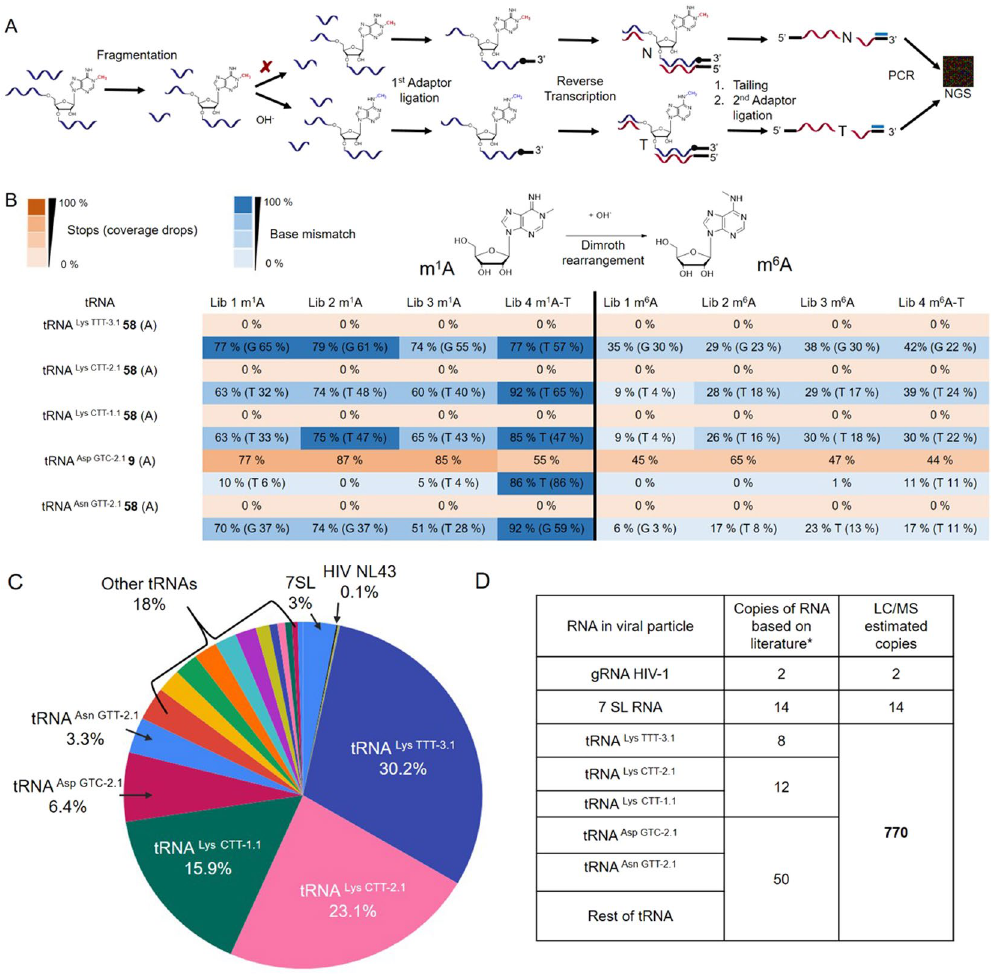
Figure 2. m 1 A profiling of RNAs in HIV-1 virion. ( A ) Scheme showing the preparation of the deep sequencing libraries of RNA isolated from HIV-1 virions. ( B ) Table showing the observed misincorporation (blue) or arrests (orange) of reverse transcriptase in the deep sequencing libraries. T stands for library Lib4 prepared with TGIRT reverse transcriptase, while Lib1-Lib3 libraries were prepared with SuperScript TM III reverse transcriptase. ( C ) The percentages of the most abundant RNA reads in the deep sequencing libraries. ( D ) Table showing the ∗ extrapolated numbers of copies of RNAs in HIV-1 virion based on literature ( ) 17,18 and on our LC/MS